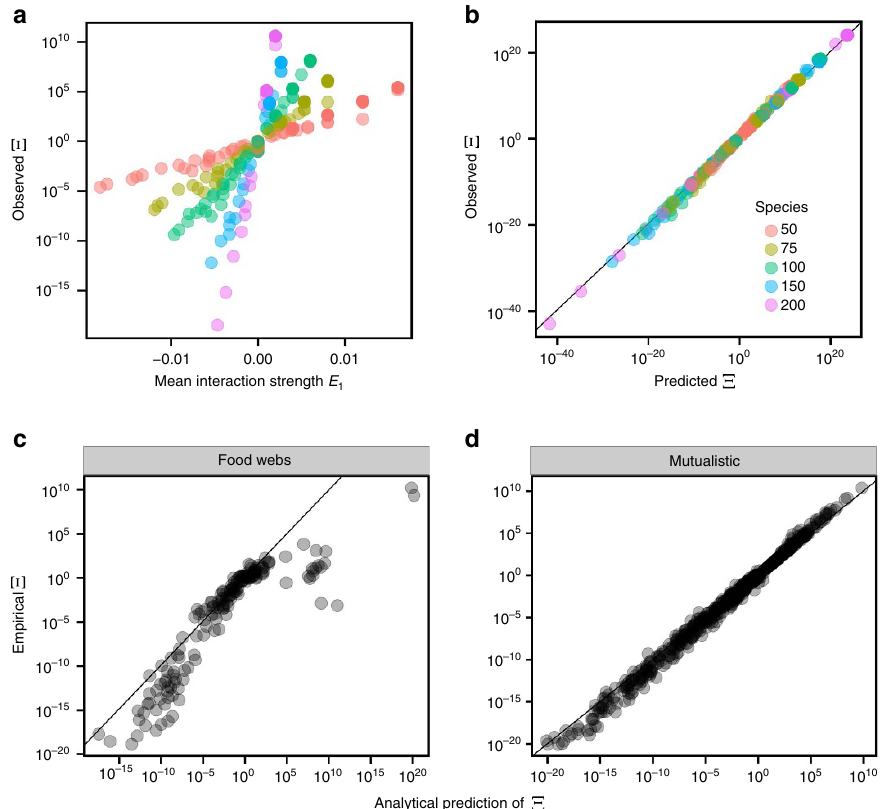
Figure 2 | Feasibility domain in random and empirical webs. The top two panels show X , the size of the domain of growth rates leading to coexistence, in the case of random networks. ( a ) The dependence of X on E 1 ¼ C m (where C is the connectance and m is the mean interaction strength), and the number of species S . ( b ) The match between our analytical prediction (equation (2) and Supplementary Note 6) and the numerical value of X . The bottom panels show a comparison between X computed for empirical webs (89 mutualistic networks in d , and 15 food webs in c , parameterized with different distributions of interaction strengths) and our analytical approximation. Mutualistic networks have values of X comparable to random networks with similar interactions ( R 2 ¼ 0.98), indicating that their structure has little effect on the size of the feasibility domain. Food webs have lower values of X than their random counterparts ( R 2 ¼ 0.80). Empirical networks were parameterized extracting interaction strengths from a bivariate normal distribution with different means, variances and correlations (see and Supplementary Note